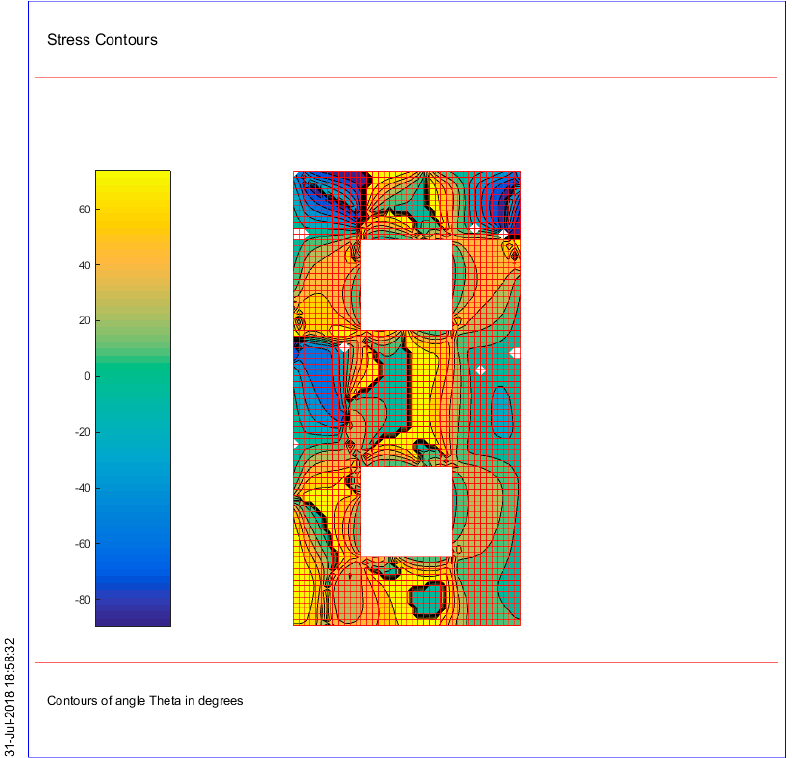
Figure 23. Contours of angle theta (PGA = 0.40 g).